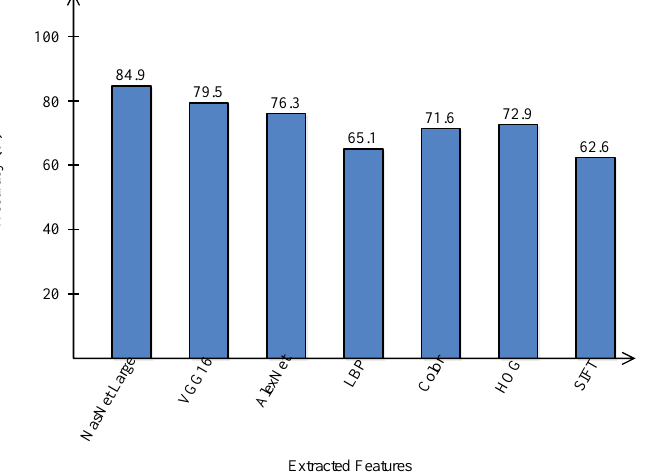
Figure 13. Comparison of deep learning and traditional features in terms of accuracy on HAM10000 dataset.